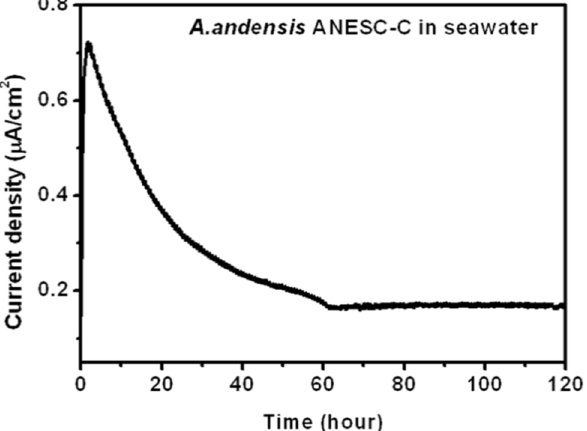
Fig 7. Current density vs. time graph of A . andensis ANESC-S T in seawater fed MFCs. Data represents an average of